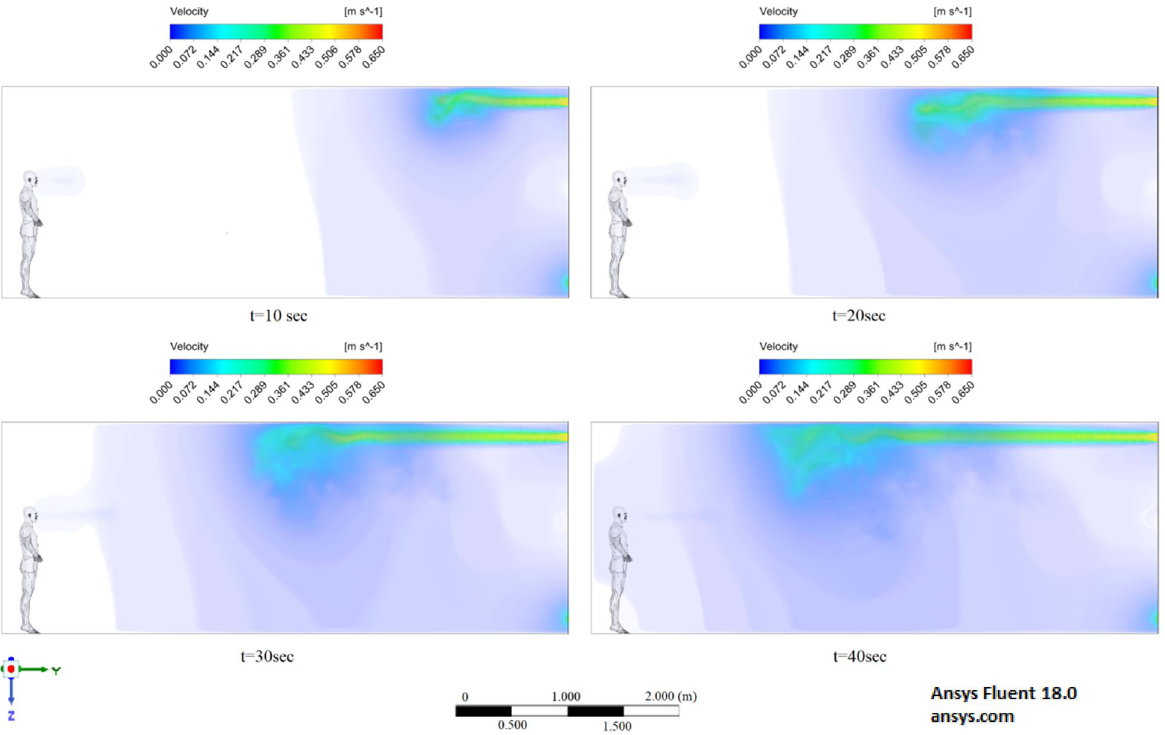
Figure 12. Velocity contours for cough = 1 m/s and ventilation = 0.5 m/s.